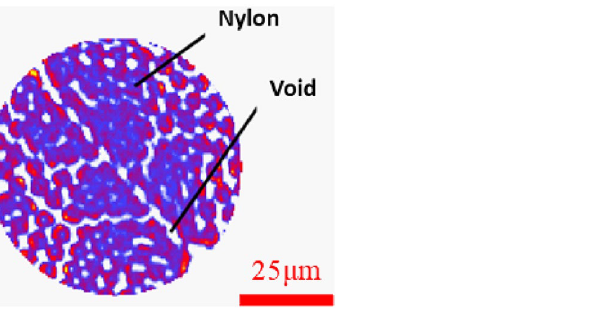
Figure 8. The division diagram of nylon and void (the purple part is nylon, and the white part inside is pore).